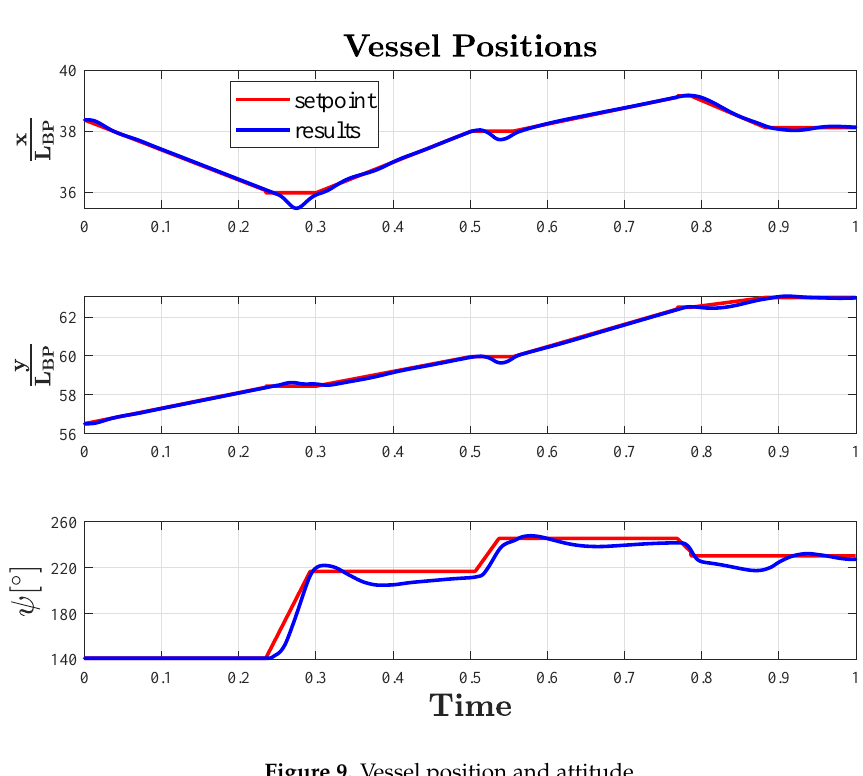
Figure 9. Vessel position and attitude.